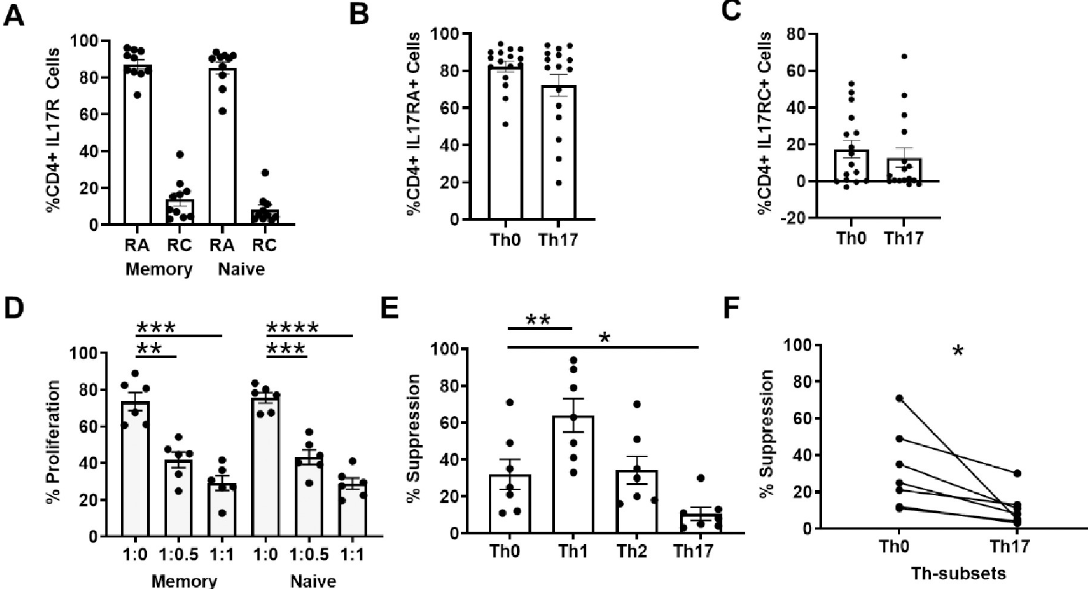
Fig 2. IL-17RA/RC receptor expression does not account for the lack of memory cell response to IL-17. A. IL17RA and IL17RC expression on ex vivo microbead-sorted CD4 + Na ï ve (CD45RA + and CD45RO - ) and CD4 + Memory (CD45RO + and CD45RA - ) T-cells (Mean+/-SEM; n = 9). B-C. IL17RA and IL17RC expression after 7-day differentiation cultures of Na ï ve CD4 + T cells into Th0 and Th17 conditions (Mean+/-SEM; n = 16). D. Ex vivo-purified memory (CD4 + CD25 - CD45RO + ) and na ï ve (CD4 + CD25 - CD45RO - ) T-cells from healthy donors were stained with CFSE, followed by a 7-day culture with autologous irradiated APCs, fixed α CD3 antibody, and +/- increasing numbers of CD8 + T-cells (at the indicated ratios). Column bars depict %proliferation (+/-SEM) of indicated CD4 + T-cells at the indicated CD4:CD8 ratios, showing similar proliferation at 1:0 and similar suppression at 1:0.5 and 1:1. ** p < 0.005, *** p < 0.001, **** p < 0.0001 by paired student t test; n = 6. E-F. Ex vivo -purified memory CD4 + CD25 - CD45RO + T-cells from healthy donors were polarized under indicated differentiation conditions for 7 days and then placed in a 7-day CD8 + T-cell mediated suppression assay. (E) Column bars depict %suppression (+/-SEM) of indicated Th-subsets by CD8 + T-cells at the 1:0.5 CD4:CD8 ratio, showing greater sensitivity of “Th1 milieu”-exposed cells and greater resistance by “Th17 milieu”-exposed cells. (F) Paired %suppression data from the Th0 and Th17 suppression cultures. * p < 0.05, ** p < 0.005.